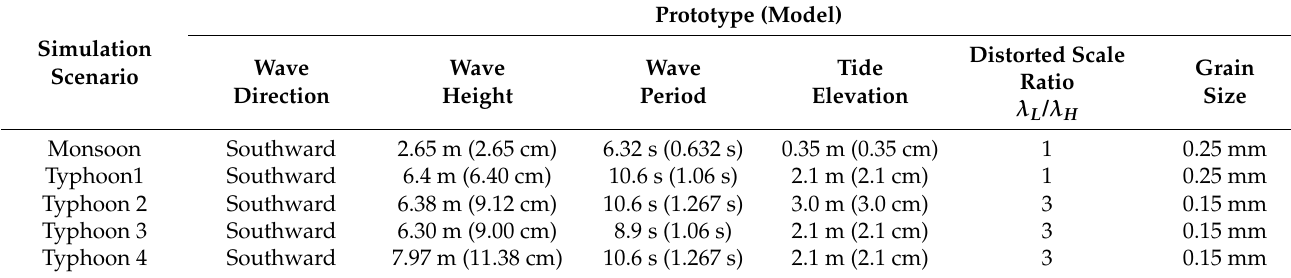
Table 2. Test scenarios and corresponding scale ratios and grain